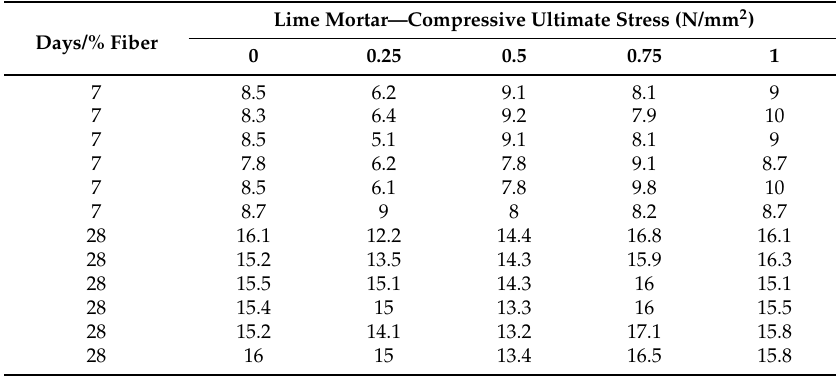
Table 2. Compression tests for lime